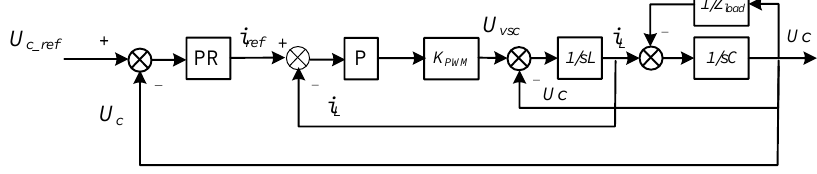
Figure 7. Double closed loop control block diagram of VSC at inverter side.